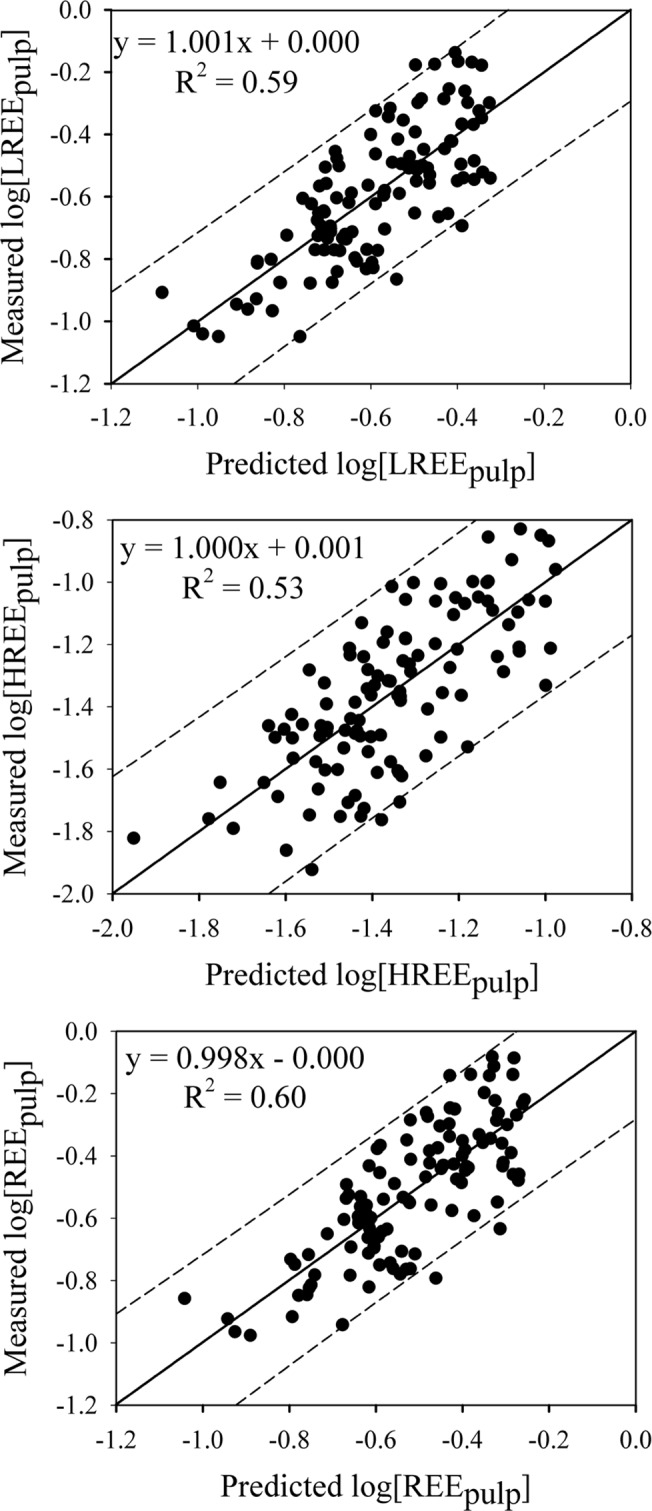
Relationship between the measured log[REEpulp] and the predicted log[REEsoil].